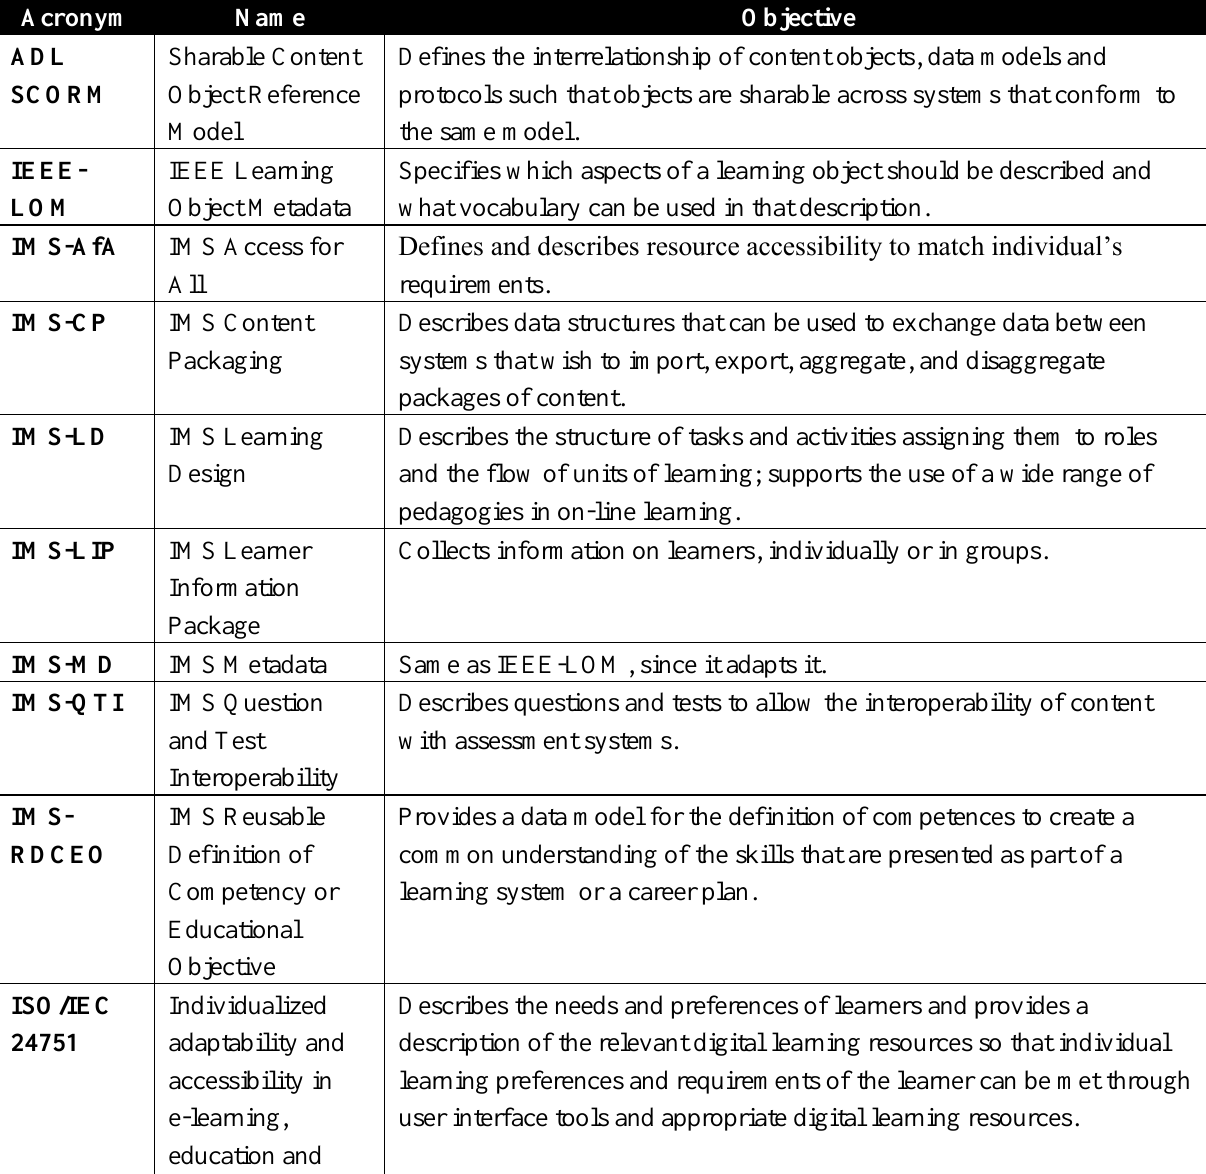
Table 1. Standards for personalization and